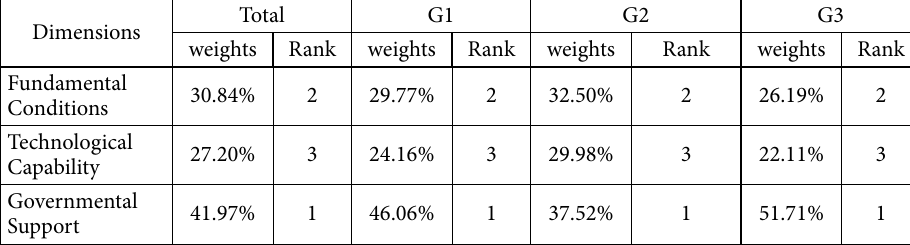
Table 3. The weights and ranks of the three evaluation dimensions